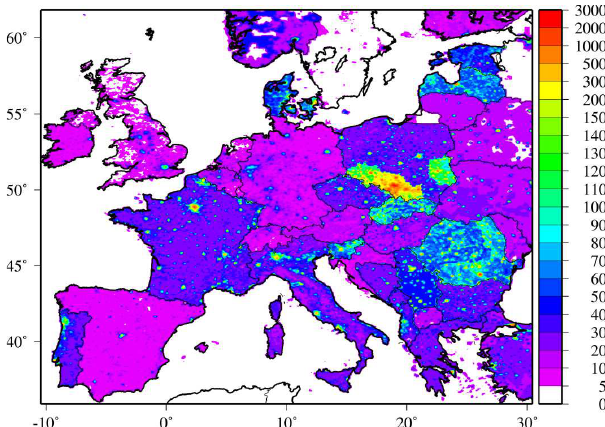
Figure 4. Total annual primary particle material emission with aerodynamic diameter ≤ 2.5µm from SNAP 2 for the year 2009 (gkm − 2 )